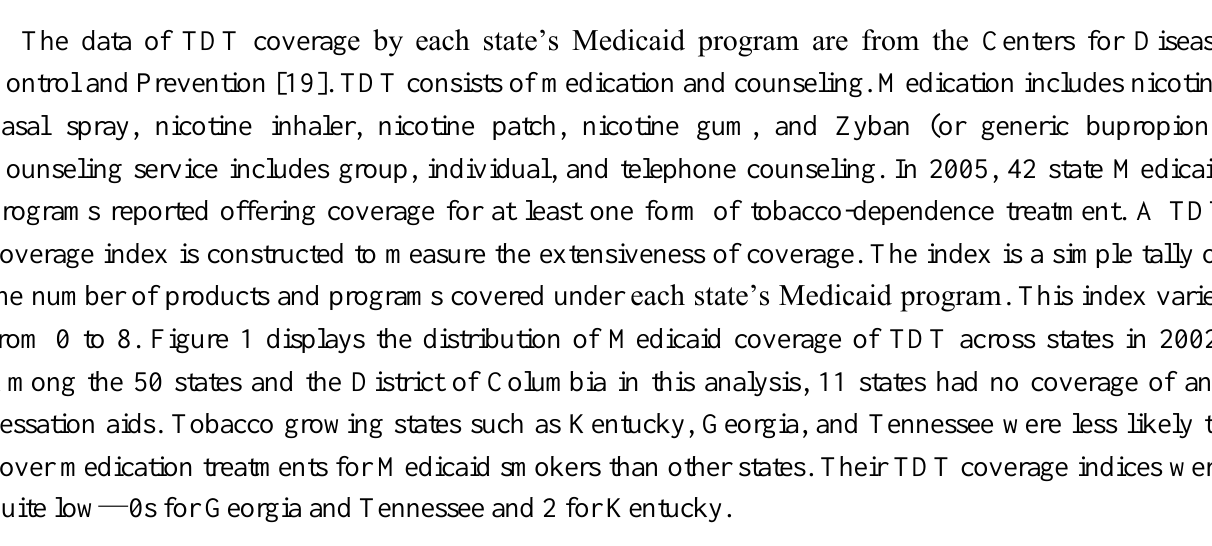
Figure 1. Medicaid Coverage of Tobacco Dependence Treatments in